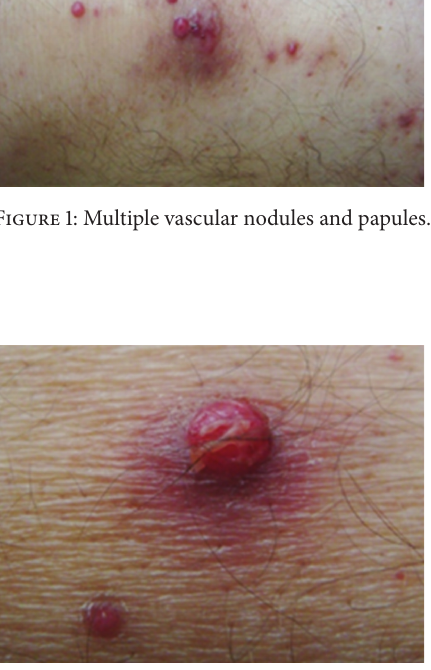
Figure 2: Angioma-like lesions with surrounding erythematous halo.